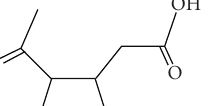
e ff ect of glutamate in neurodegenerative models, as well as to distinguish other ionotropic receptors for glutamate.